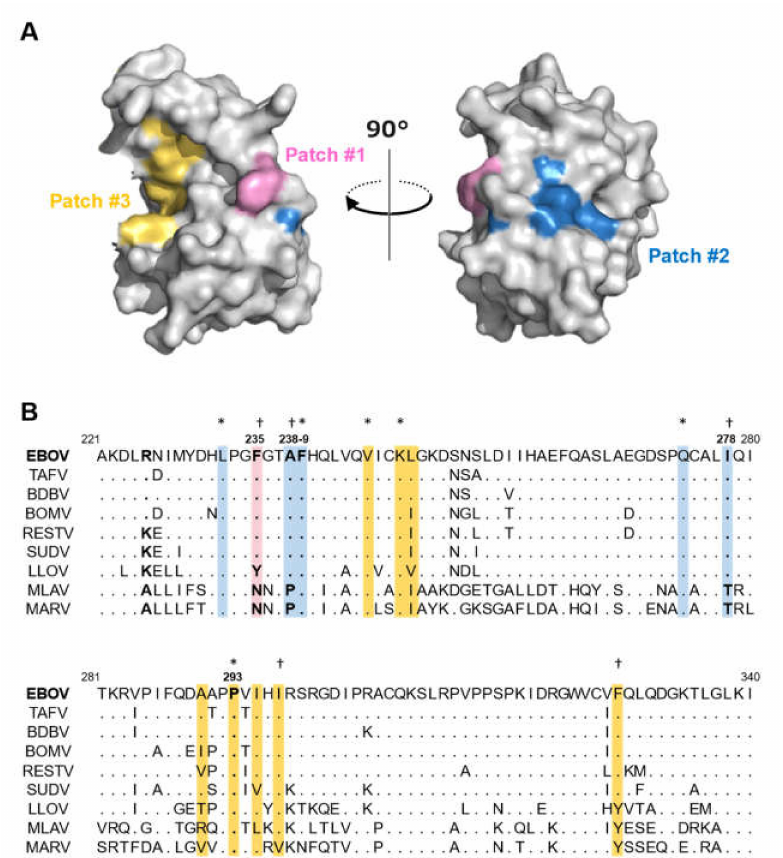
Figure 1. Hydrophobic patches on the VP35 IID surface ( A ) Three hydrophobic patches are shown on a structural model of VP35 IID (PDB ID: 3FKE). Patch #1 contains a single residue F235 (red). Patch #2 contains residues L232, A238, F239, Q274, and I278 (blue). Patch #3 contains residues V245, K248, L249, A290, P293, I295, I297, and F328 (yellow). ( B ) Multiple amino acid sequence alignment of VP35 IID among filovirus species. Highlighted amino acids represent those involved in the respective hydrophobic patches (red: patch #1, blue: #2, yellow: #3). Amino acids that are conserved among filoviruses and ebolaviruses are indicated by asterisks and daggers,